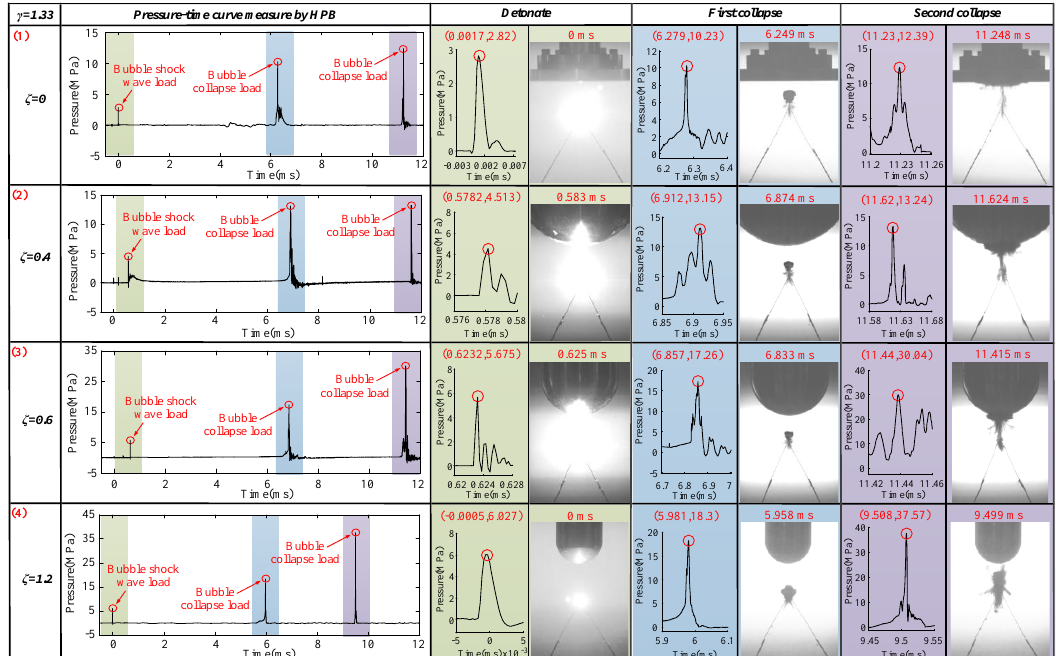
Figure 20. Pressure–time diagram for γ = 1.33 and different ζ values. The first row shows the pressure–time curves for the states of ζ = 0 and γ = 1.33. The second row shows the pressure–time curves for the states of ζ = 0.4 and γ = 1.33. The third row shows the pressure–time curves for the states of ζ = 0.6 and γ = 1.33. The fourth row shows the pressure–time curves for the states of ζ = 1.2 and γ = 1.33.